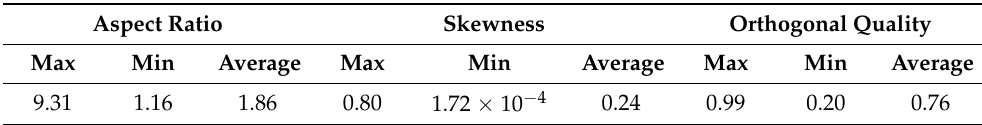
Figure 5. Meshing of the domain. Table 2. Quality of mesh design geometry. Table 2. Quality of mesh design